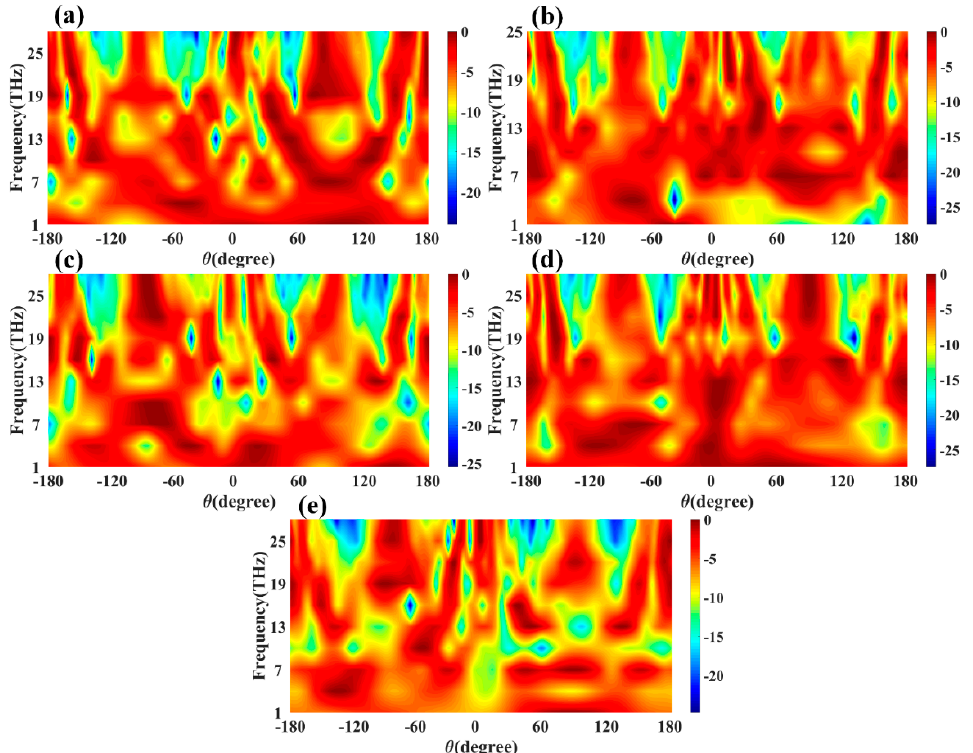
Figure 15. Calculated normalized gain variation for the frequency and theta (degree) variation. The contour plot of gain variation is plotted for ( a ) Design 1, ( b ) Design 2, ( c ) Design 3, ( d ) Design 4, and ( e ) Design 5 of the proposed antenna structures.